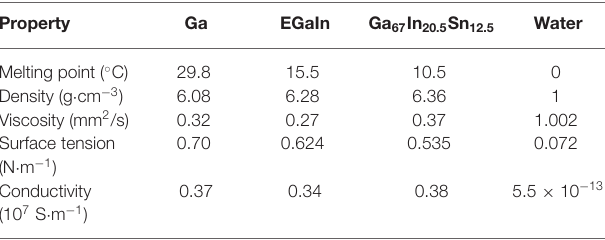
TABLE 1 | A comparison of the physical properties between several typical liquid metals (Morley et al., 2008) and water.